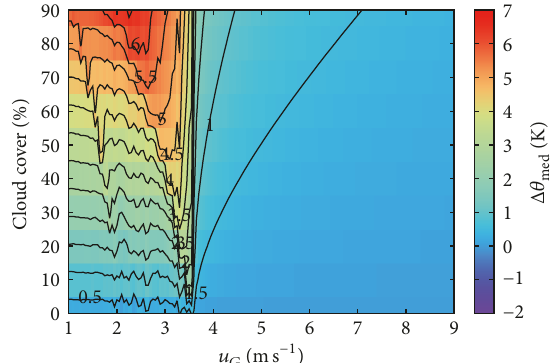
Figure 7: Temperature differences considering the variation on the cloud cover from 0 to 90%. The CO 2 concentration is considered being double the actual